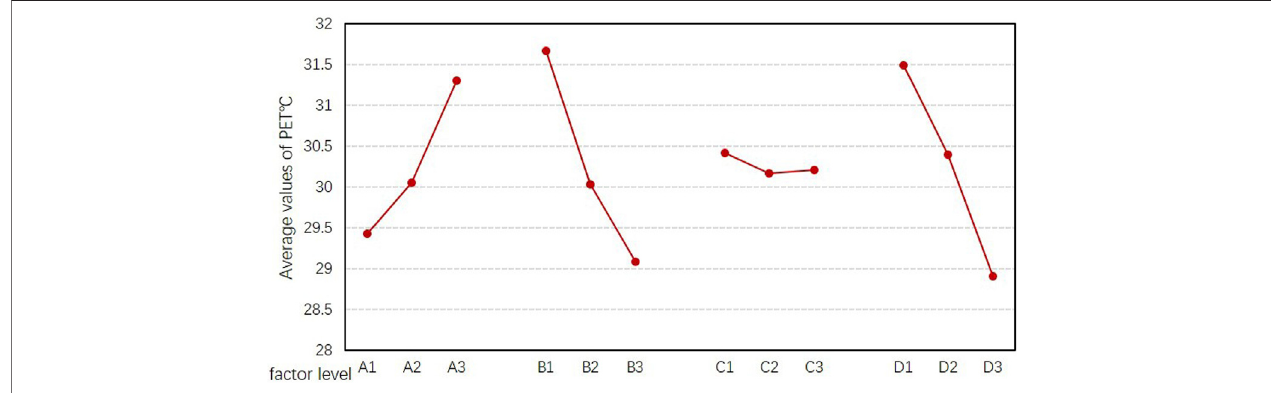
FIGURE 14 | Average values of PET from 800 to 2000 in canyons with different factor levels.